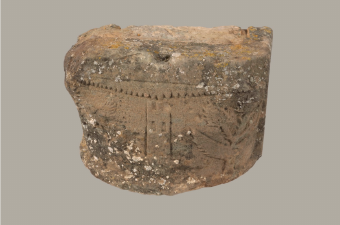
Figure 4. Capital with the weapons of De Torroja and Cardona in a capital of the Castle of Castellvell de Solsona (currently in the Diocesan Museum of